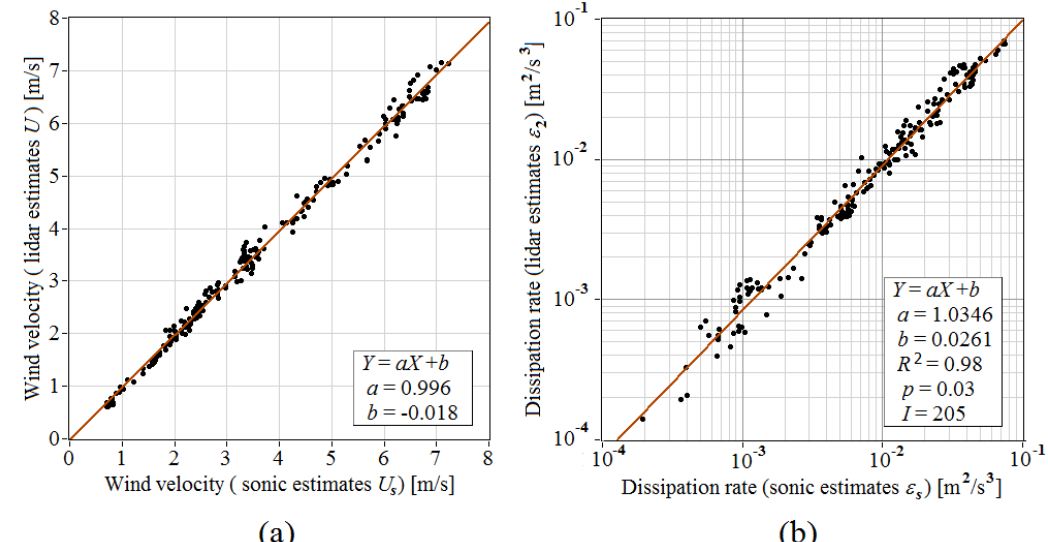
Figure 9. Comparison of the estimates of the mean wind velocity ( a ) and turbulent energy dissipation rate ( b ) obtained from simultaneous measurements by the lidar (vertical axes) and the sonic anemometer (horizontal axes). The data are taken from Figure 8. In ( a ) and ( b ), the brown line is the best fit given by equation Y i = aX i + b , where X i = U s ( a ) and X i = lg ( ε s ) ( b ). Remote Sens. 2020 , 12 , x FOR PEER REVIEW